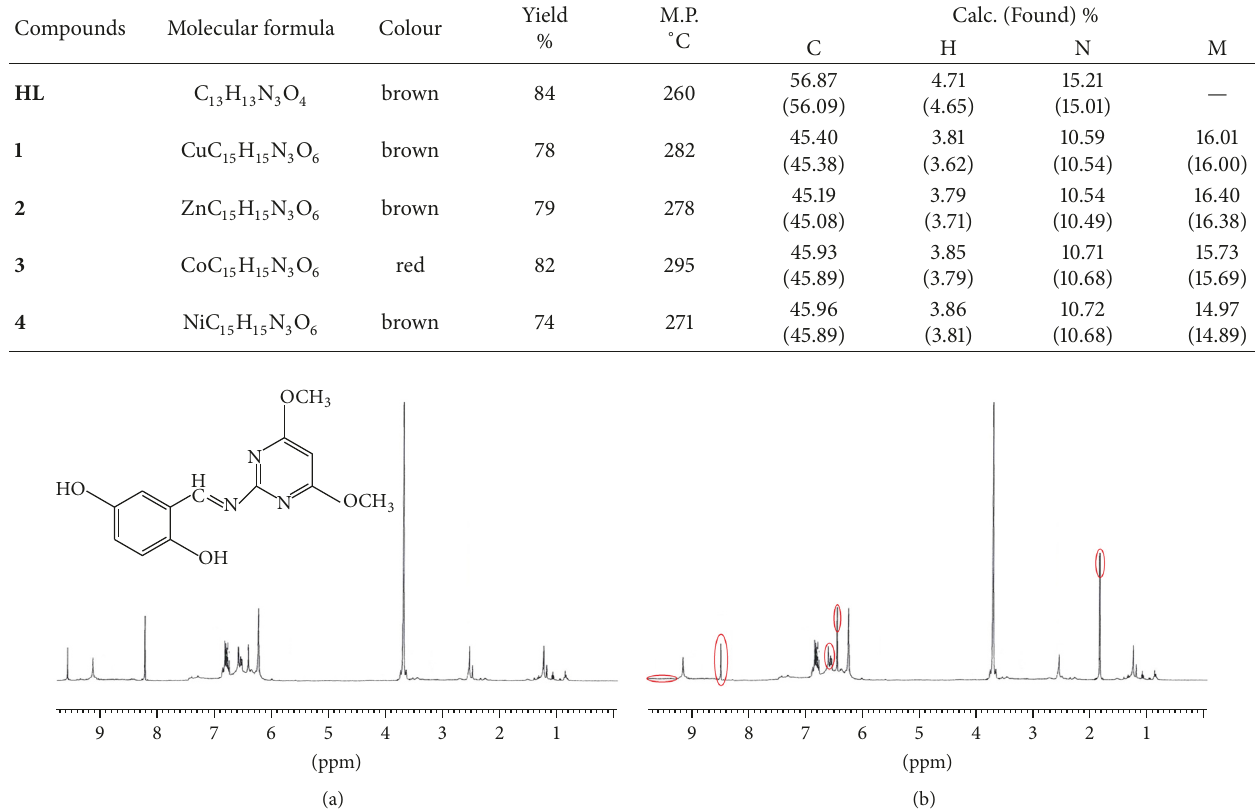
Figure 1: 1 H-NMR spectra of (a) ligand HL and (b) complex 2